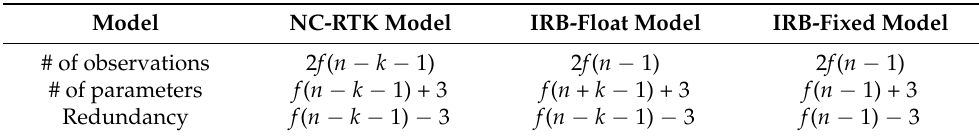
Table 1. Model redundancy